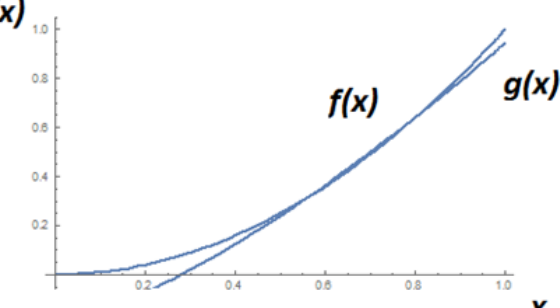
Figure 4: The curve f ( x ) with its fractional tangent space g ( x ) in the original